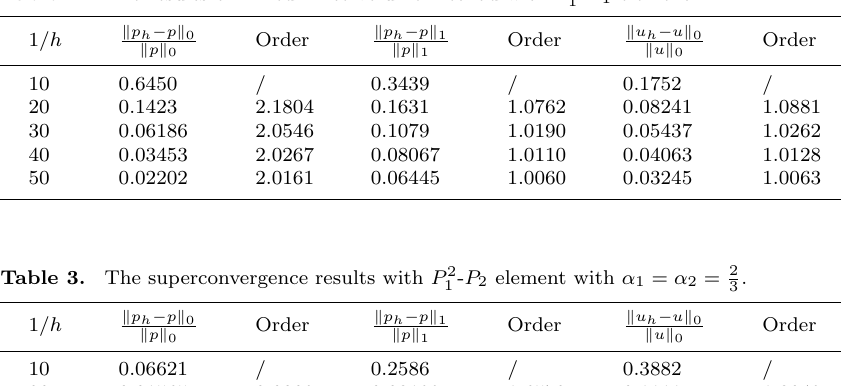
Table 2. The results of mixed finite volume method with P 2 1 /h